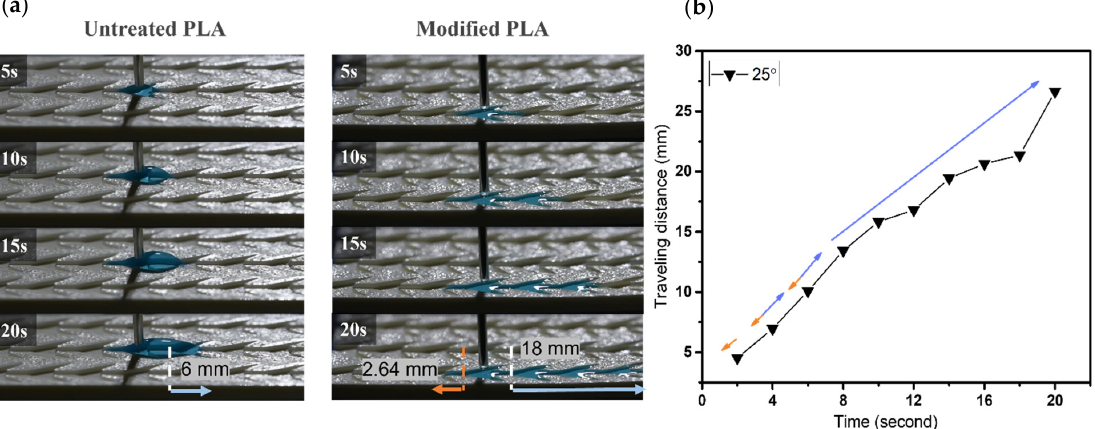
Figure 9. ( a ) The dynamic wetting behavior of water droplets in the 3D-printed dart-shaped pattern with α angle of 25 ° ; ( b ) Plot of traveling distance versus time with the directions of droplet movement wetting of modified pattern. The orange arrow denotes the opposite side, and the blue one denotes the predominant side.